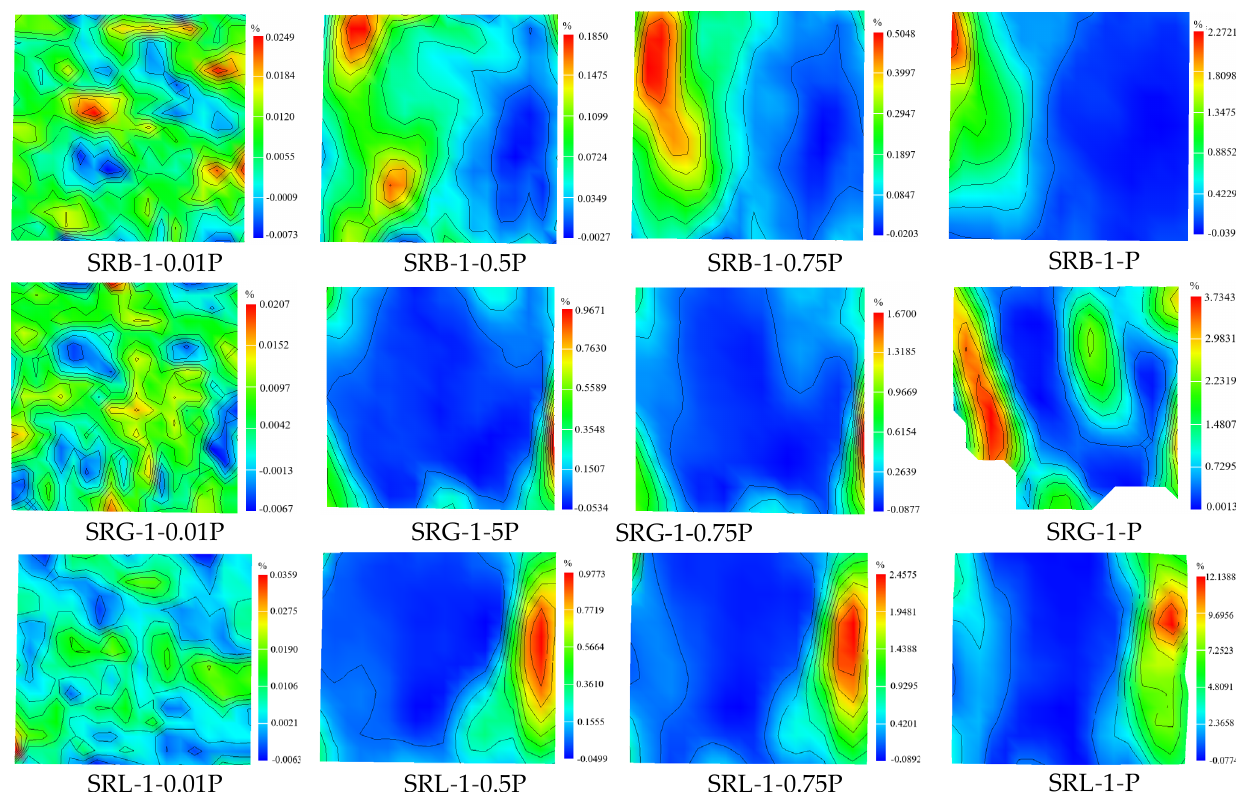
Figure 5. Major strain cloud diagrams of the rock specimens.